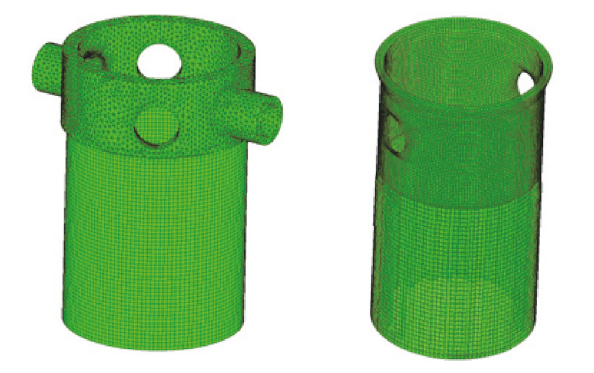
Figure 9: Grid of the core